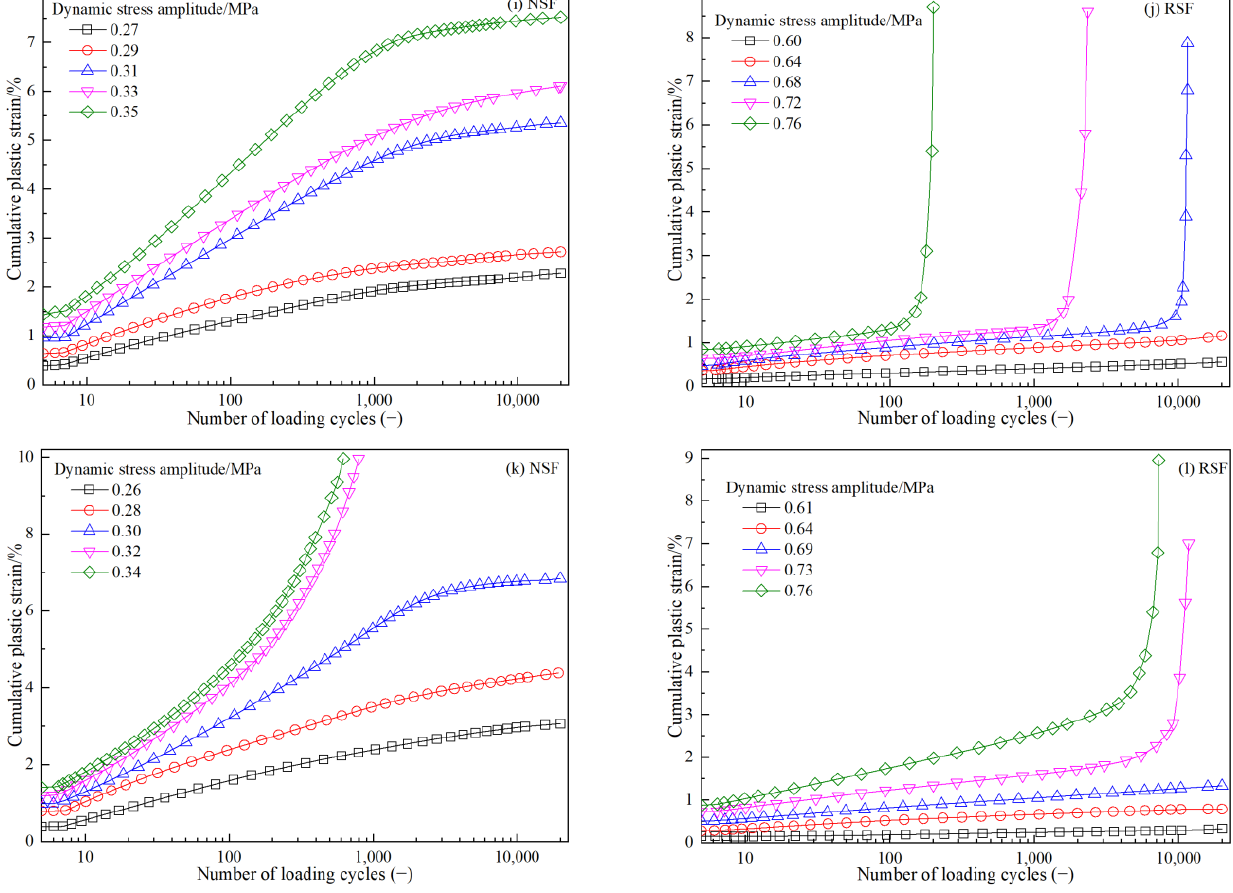
Figure 5. CPS and vibration number curves of subgrade filler under different FT cycles. ( a ) for NSF with FT cycle of 0, ( b ) for RSF with FT cycle of 0 ( c ) for NSF with FT cycle of 1, ( d ) for RSF with FT cycle of 1 ( e ) for NSF with FT cycle of 3, ( f ) for RSF with FT cycle of 3 ( g ) for NSF with FT cycle of 5, ( h ) for RSF with FT cycle of 5 ( i ) for NSF with FT cycle of 7, ( j ) for RSF with FT cycle of 7 ( k ) for NSF with FT cycle of 9, ( l ) for RSF with FT cycle of 9.